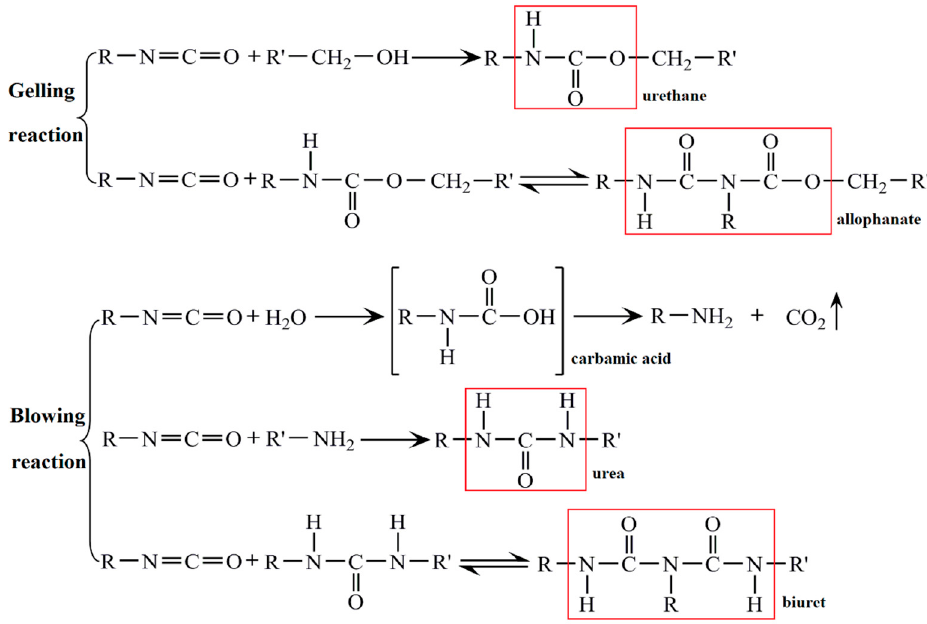
Figure 7. Scheme of gelling and blowing reactions in the synthesis of polyurethane foam.